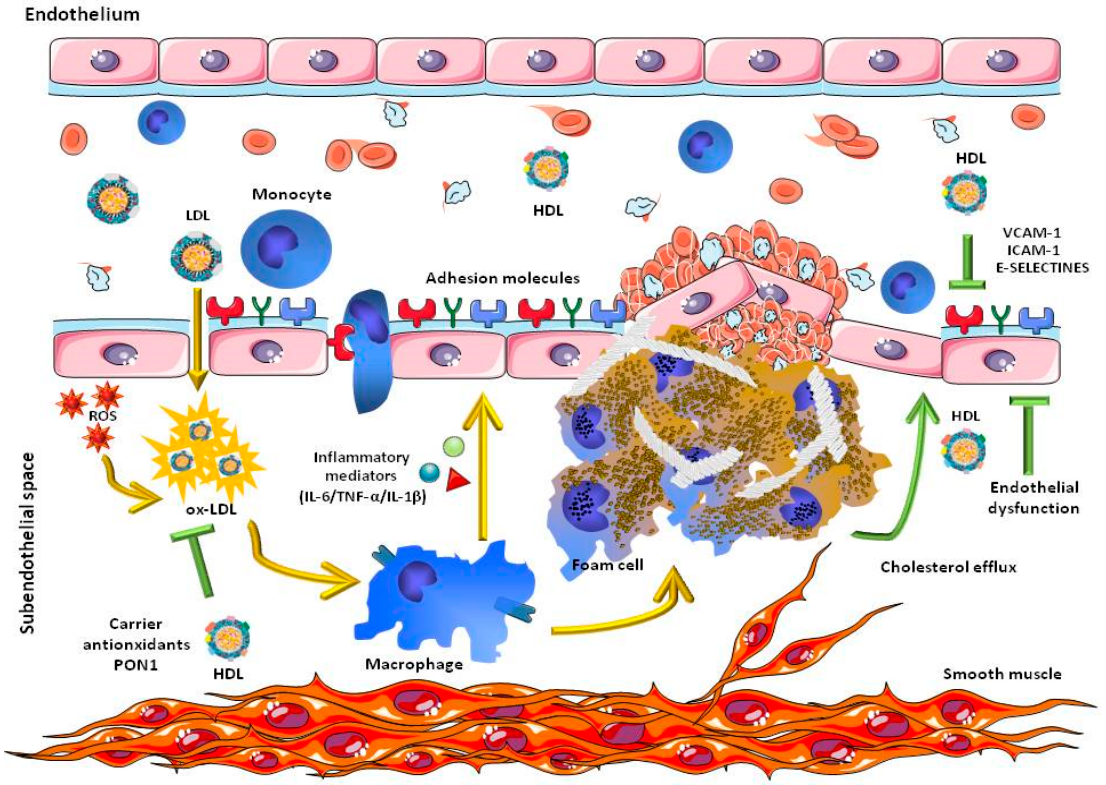
Figure 2. Cardioprotective function of HDL. The main cardioprotective properties of HDL include the inhibition of the oxidation of LDL (ox-LDL) through the activity of paraoxonase 1 (PON1) and the transport of antioxidant molecules, the inhibition of the expression of adhesion molecules in inflammatory processes and the efflux of cholesterol, decreasing the endothelial dysfunction. IL = interleukin; TNF = tumor necrosis factor; ROS = reactive oxygen species. VCAM-1 = vascular cell adhesion molecule 1; ICAM-1 intercellular adhesion molecule 1.